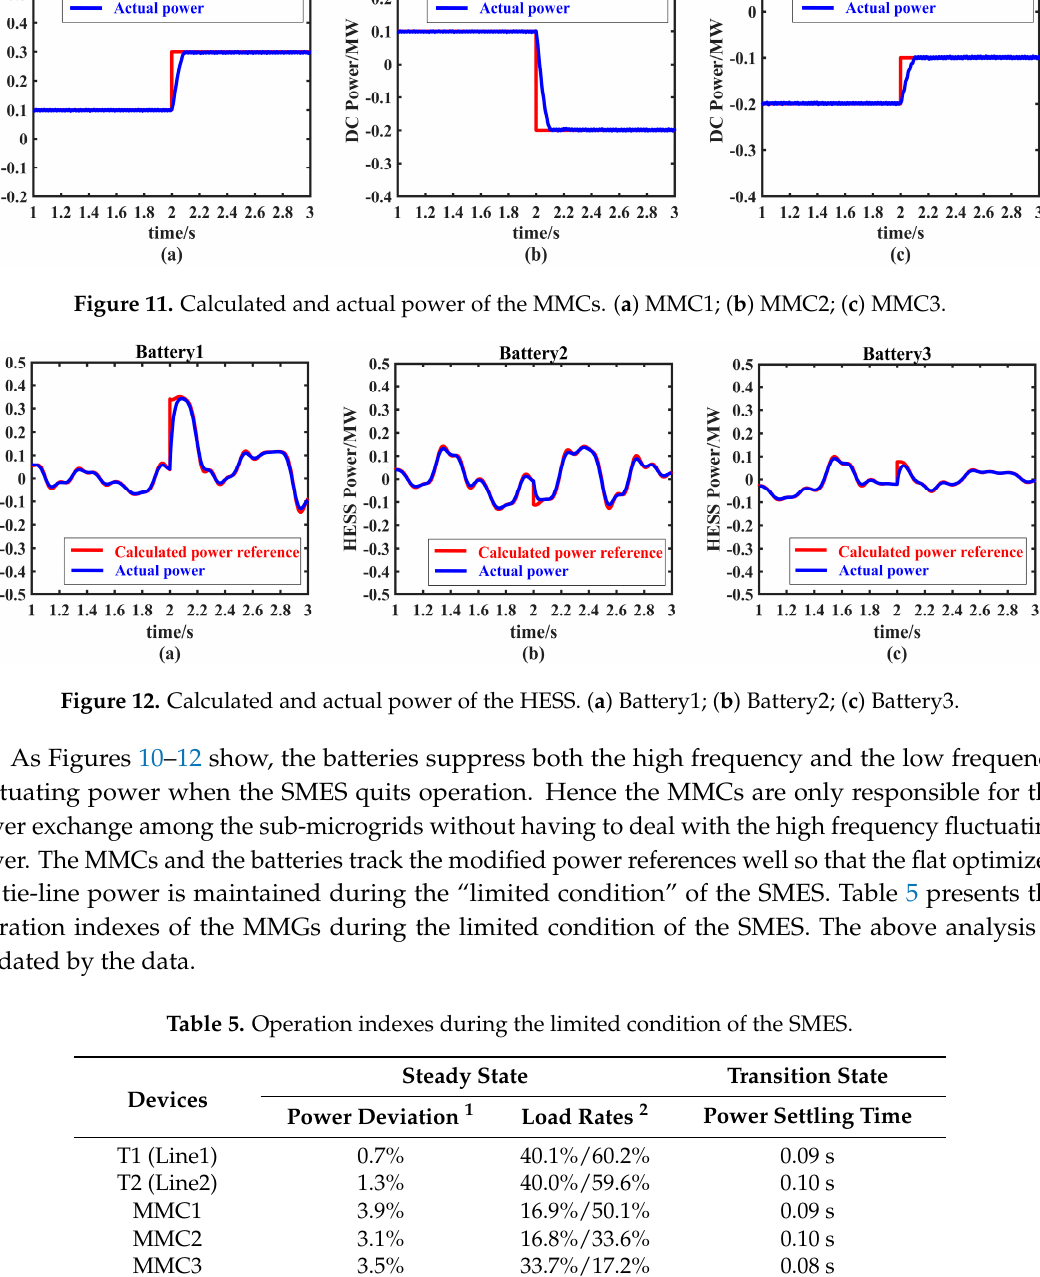
Figure 10. Actual AC tie-line power during the “limited condition” of the SMES. ( a ) AC tie-line 1; ( b ) AC tie-line 2.